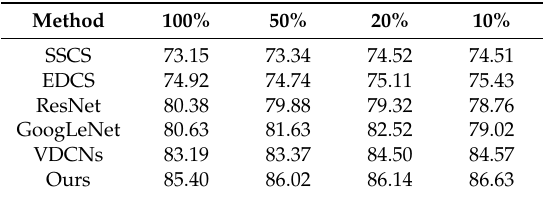
Table 5. Comparison of classification rates on Dataset 1 under different resolutions.